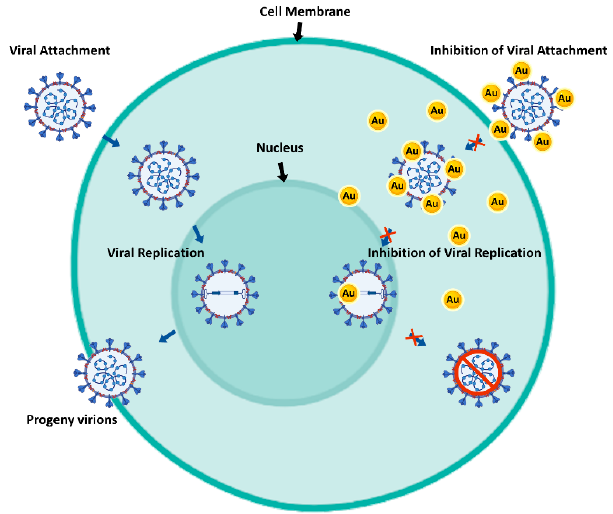
Figure 1. Representative mechanism of the antiviral properties of Au-NPs. On the left, a normal mechanism by which a virus infects a host cell (in this case, a eukaryotic cell) can be seen: firstly, viral attachment to the cell membrane occurs, followed by penetration into the cytoplasm; then the virus proceeds to use the cellular mechanisms to replicate its genetical material, generating virions to continue the infectious cycle. On the right, is shown a mechanism of inhibition by which Au-NPs can intervene, either by attaching themselves to the virus, blocking its attachment to the cell and consequent entry in the cell and ultimately interfering with the mechanisms of viral replication inside the cell (adapted from [88]).